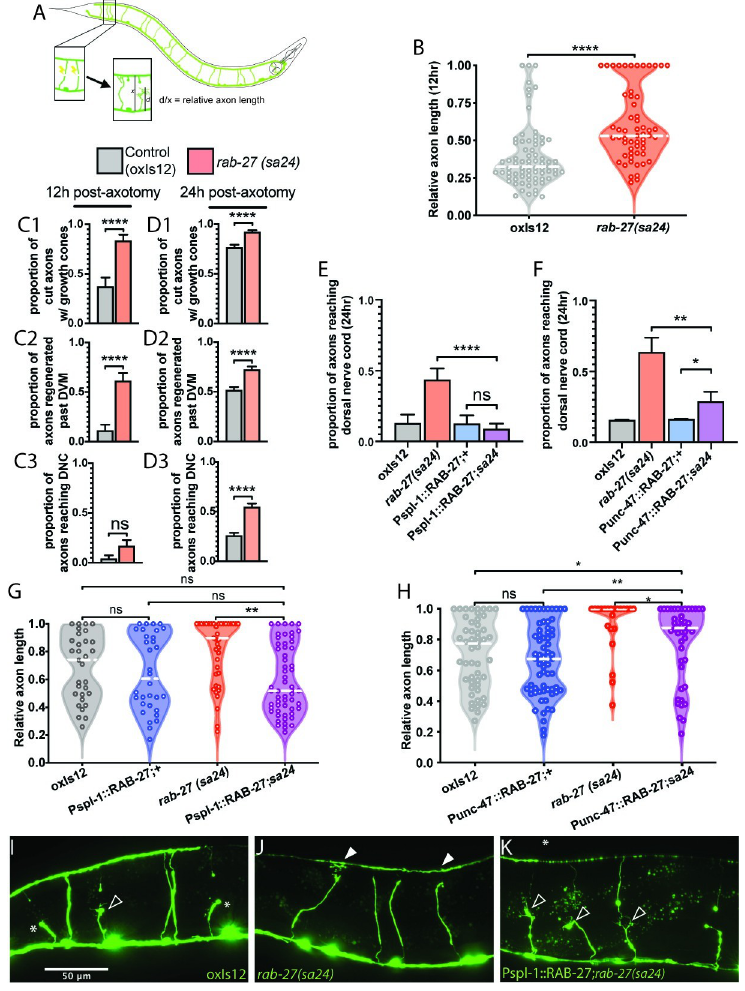
Fig 1. RAB-27 expression in the intestine inhibits axon regeneration. (A) Posterior DD/VD commissural axons in the GABAergic nervous system of L4 animals were severed using a pulsed laser, and regeneration was measured after a 24 hour recovery window. (B) Relative axon length in control ( oxIs12 ) animals and rab-27 ( sa24 ) mutants after 12 hours of recovery after axotomy. Axons cut per genotype, L to R: 75, 57. Kolmogorov-Smirnov test was used. ns, not significant, � p < 0.05, ��� p < 0.0005. (C). Proportion of cut axons forming growth cones (C1), regeneration past the dorsoventral midline (DVM) (C2), or full regeneration back to the dorsal nerve cord (DNC) (C3) in control ( oxIs12 ) and rab-27 ( sa24 ) mutant animals after 12 hours of recovery post-axotomy. Axons cut per genotype, L to R: 27, 36. Unpaired t-test was used. ns, not significant, ���� p < 0.0001. Error bars represent SEM. (D). Proportion of cut axons forming growth cones (D1), regeneration past the dorsoventral midline (DVM) (D2), or full regeneration back to the dorsal nerve cord (DNC) (D3) in control ( oxIs12 ) and rab-27 ( sa24 ) mutant animals after 24 hours of recovery post- axotomy. Axons cut per genotype, L to R: 233, 198. Unpaired t-test was used. ns, not significant, ���� p < 0.0001. Error bars represent SEM. (E) Proportion of cut axons showing signs of regeneration in control ( oxIs12 ) and rab-27 ( sa24 ) mutant animals, and animals expressing RAB-27 cDNA under an intestine-specific promoter (Pspl-1) and stabilized with rab-3 3’ UTR sequence, in both control and rab-27 mutant backgrounds. Axons were scored after 24 hours of recovery post-axotomy. Axons cut per genotype, L to R: 31, 39, 32, 57. Unpaired t-test was used. ns, not significant, ���� p < 0.0001. Error bars represent SEM. (F) Proportion of cut axons showing signs of regeneration in control ( oxIs12 ) and rab-27 ( sa24 ) mutant animals, and animals expressing RAB-27 cDNA under a GABA neuron-specific promoter (Punc-47) and stabilized with rab-3 3’ UTR sequence, in both control and rab-27 mutant backgrounds. Axons were scored after 24 hours of recovery post-axotomy. Axons cut per genotype, L to R: 51, 22, 67, 45. Unpaired t- test was used. ns, not significant, � p < 0.05, �� p < 0.005. Error bars represent SEM. (G) Relative axon length in control ( oxIs12 ) animals, rab-27 ( sa24 ) mutants, and animals expressing RAB-27 cDNA under an intestine-specific promoter and stabilized with rab-3 3’ UTR sequence, in both control and rab-27 mutant backgrounds. Number of axons cut per genotype, L to R: 31, 32, 39, 57. Kolmogorov-Smirnov test was used. ns, not significant, � p < 0.05, �� p < 0.005. (H) Relative axon length in animals expressing RAB-27 cDNA under a GABA neuron-specific promoter, in